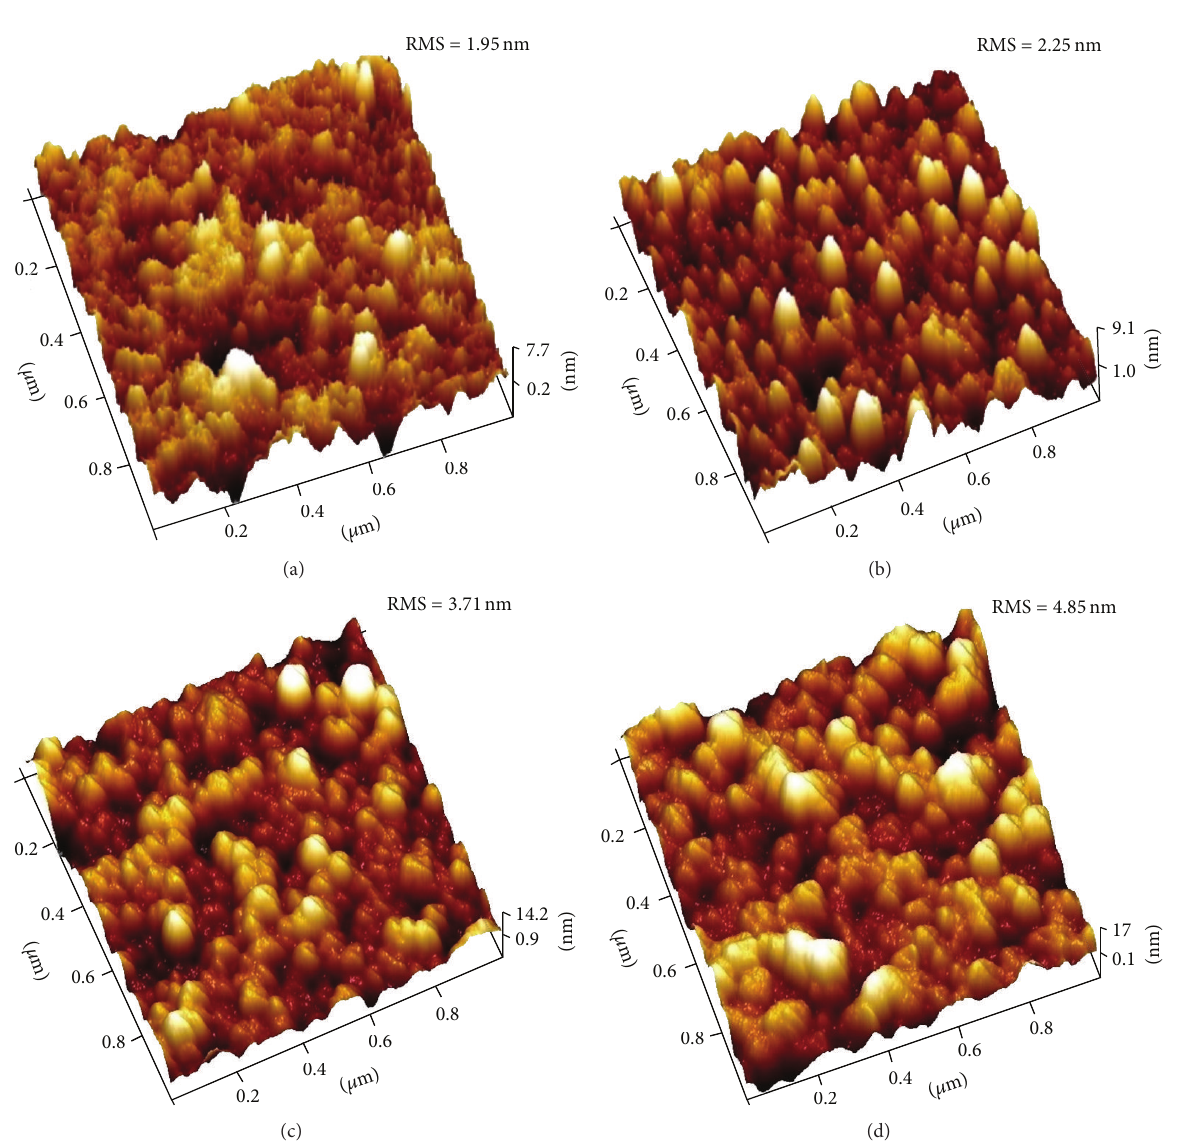
Figure 4: 3D AFM morphology images of ZnO films on ITO glass and grown at different temperatures. (a) 125 ∘ C, (b) 150 ∘ C, (c) 200 ∘ C, and (d) 250 ∘